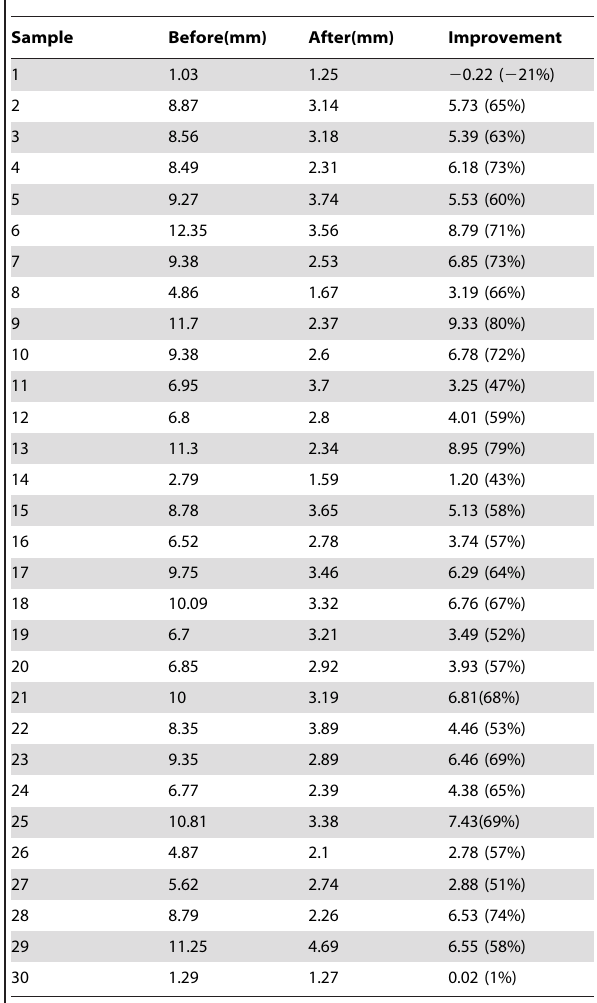
Table 2. Hausdorff Distance w.r.t Ground Truth Before and After Restoration.